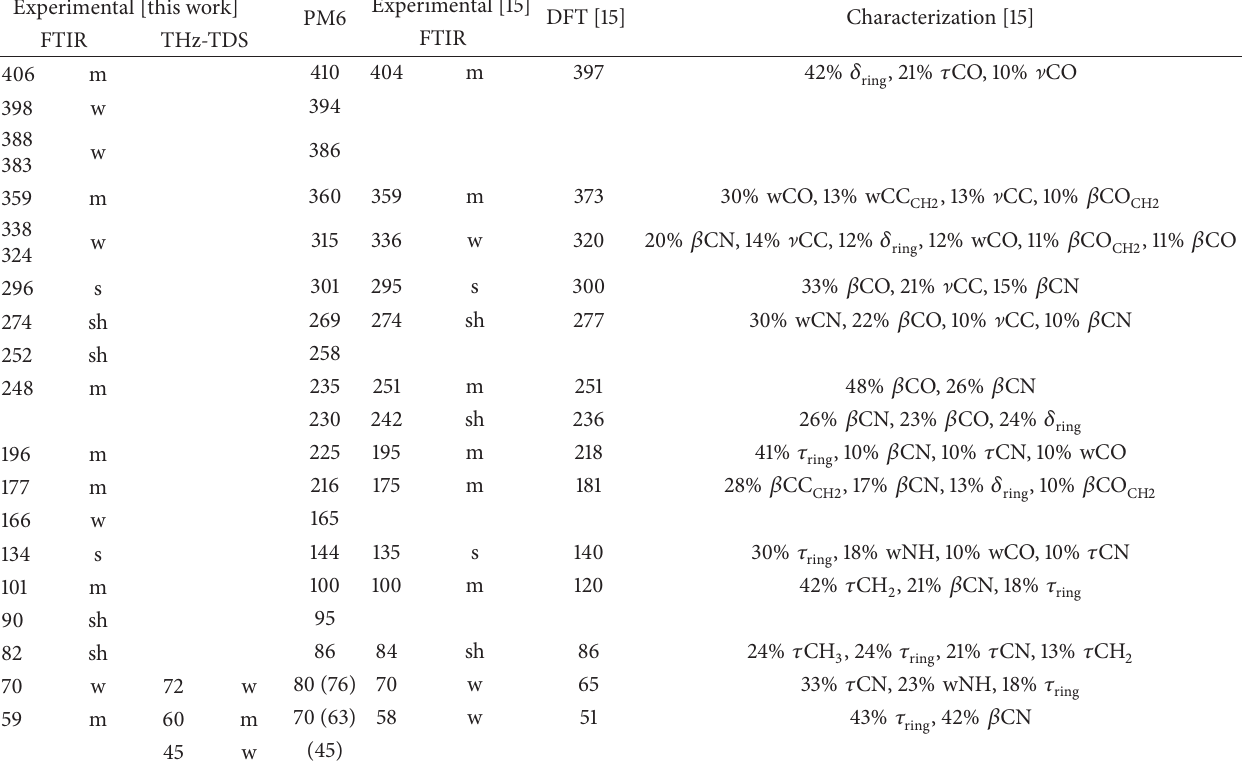
Table 3: Frequency assignment and comparison with the theoretical and experimental results of [15]. The following abbreviations have been used in the description of the vibrations: s, strong; m, medium; w, weak; sh, shoulder; ] , stretching; 𝛽 , in-plane bending; 𝛿 , deformation; 𝜔 , wagging; 𝜏 ,